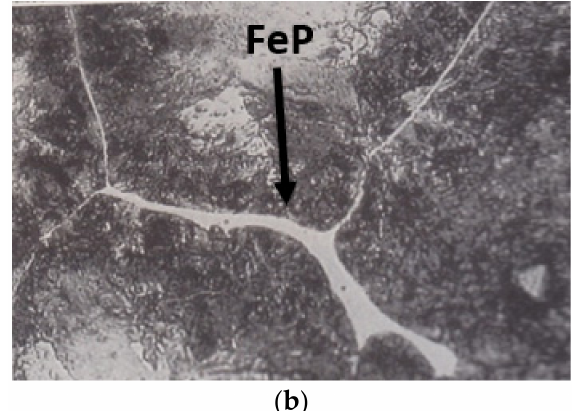
Figure 21. Influence of P on the hot ductility of high C (0.6%), low alloy steels: ( a ) hot ductility curves for as-cast C-Mn-Nb-Al and plain C-Mn steels at two levels of P, 0.007% and 0.045% ( b ) low melting point iron phosphide phase at prior austenite grain boundaries in the low P plain C-Mn steel. The base composition of the steels was 0.6% C, 2% Si, 0.8% Mn and 0.025% Al with and without 0.03% Nb [56].